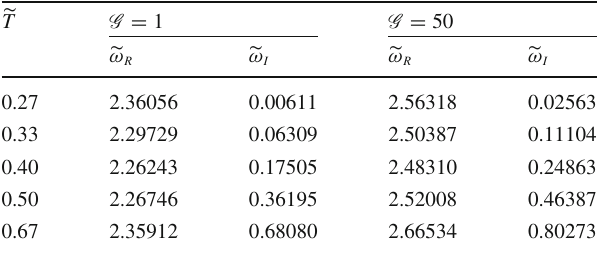
Table 4 Numerical results of the first quasinormal mode for (cid:10) q = 1 and low temperatures